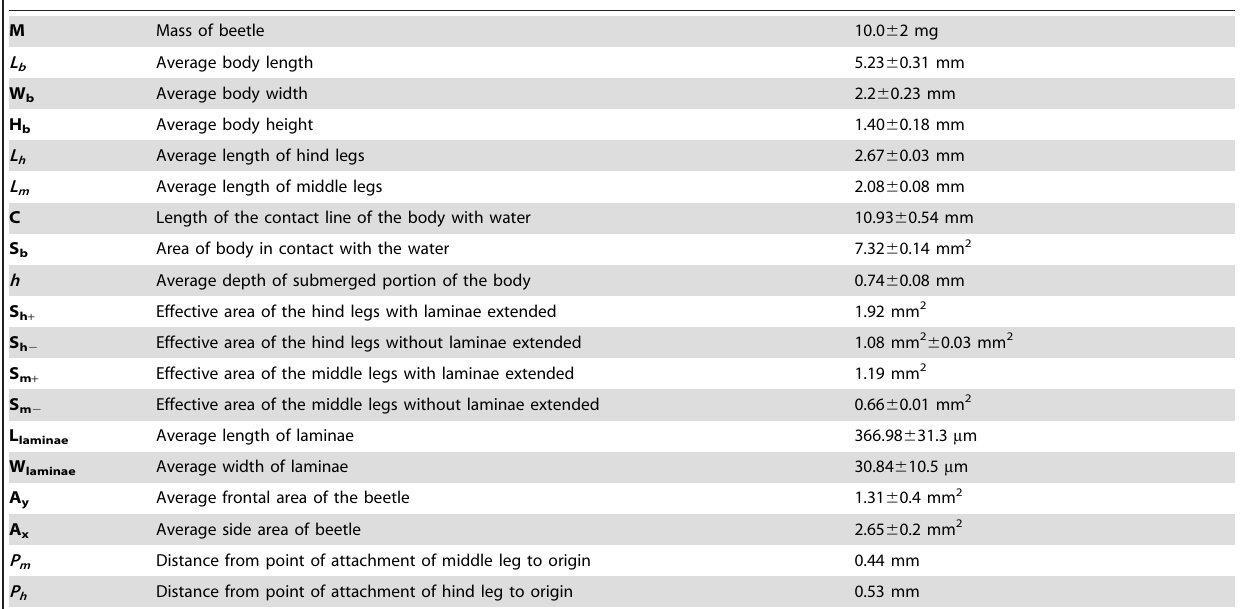
Table 1. Parameters obtained from micrographs.